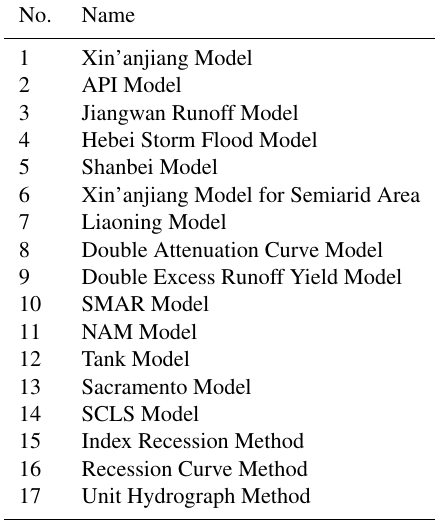
Table 1. Flood forecasting models employed in the CNFFS.